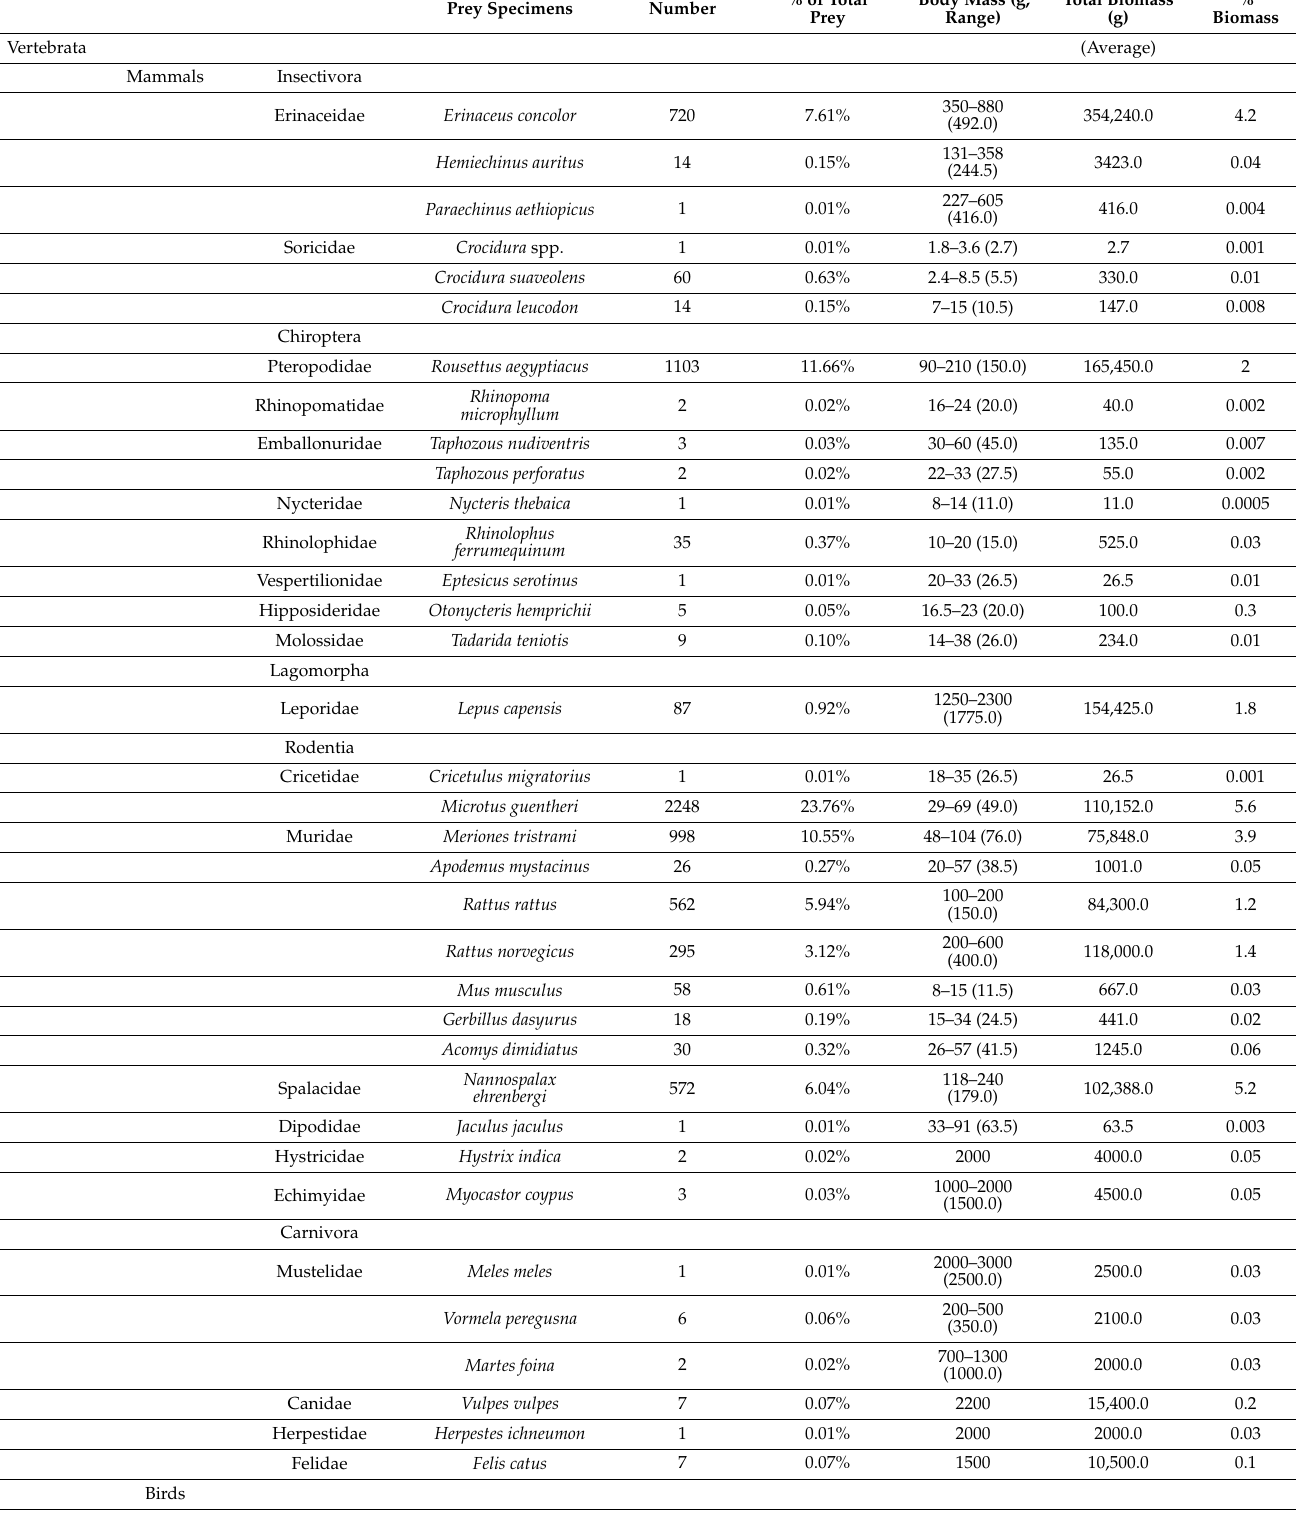
Table 2. The diet determined according to pellet remains collected from 14 nests, i.e., 43 breeding attempts, of Eagle Owls during the 2006–2009 breeding seasons in Israel. Total biomass was calculated by the average body mass of the species from the literature multiplied by the number of items. Mammal taxonomy based on